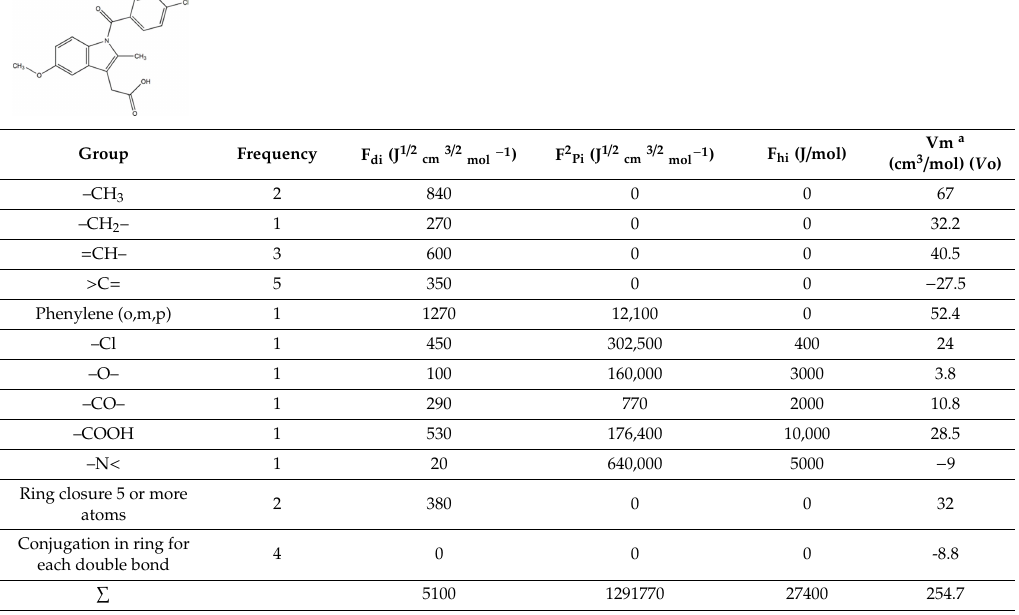
Table 3. Calculation of HSPs and molar volume for INM according to the Hoftyzer-Van Krevelen Table3. CalculationofHSPsandmolarvolumeforINMaccordingtotheHoftyzer-VanKrevelenmethod.